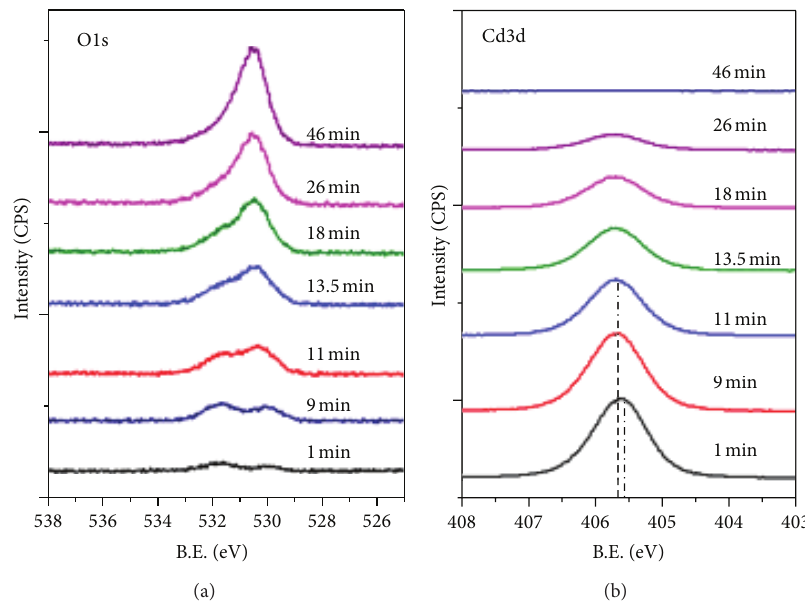
F 5: XPS spectrum of the O1s and Cd3d reigns for n-ITO/n-CdS isotype heterojunction at various pro�ling times.